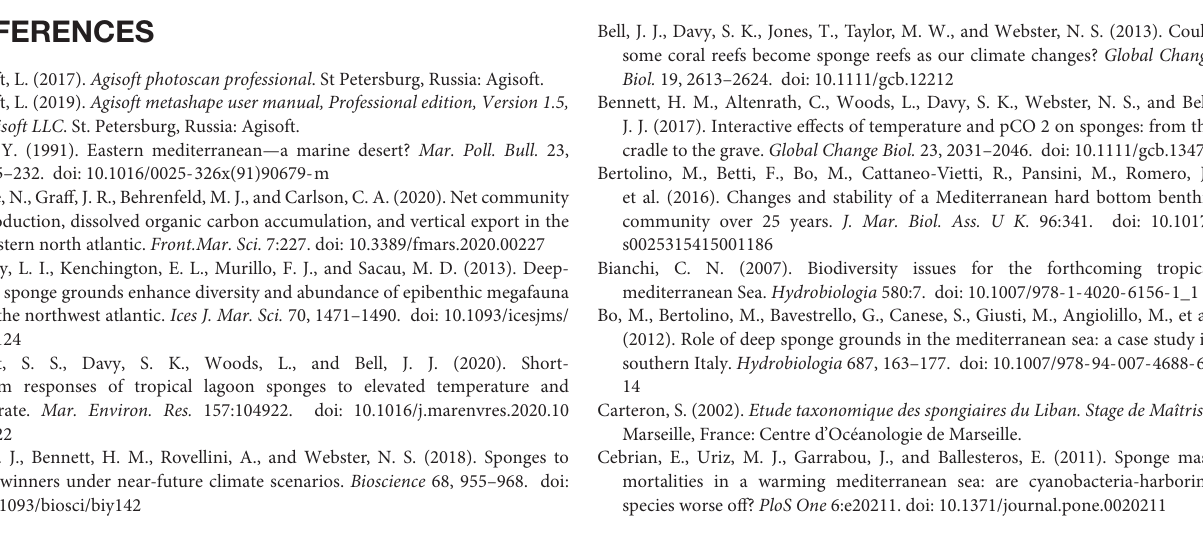
Supplementary Figure 1 | Temperature measured every 6 h by HOBO loggers placed inside and outside the crates at the translocation site off the coast of Mikhmoret at a depth of 10 m. Supplementary Figure 2 | Control specimens of A. oroides in October 2018, sponges seem alive. Supplementary Table 1 | Sponges in the transplantation experiment. Treatment 2 indicates whether the sponge was attached inside or outside a box. Initially seven sponges were attached outside the crates; two died shortly after transplantation and one was lost in a